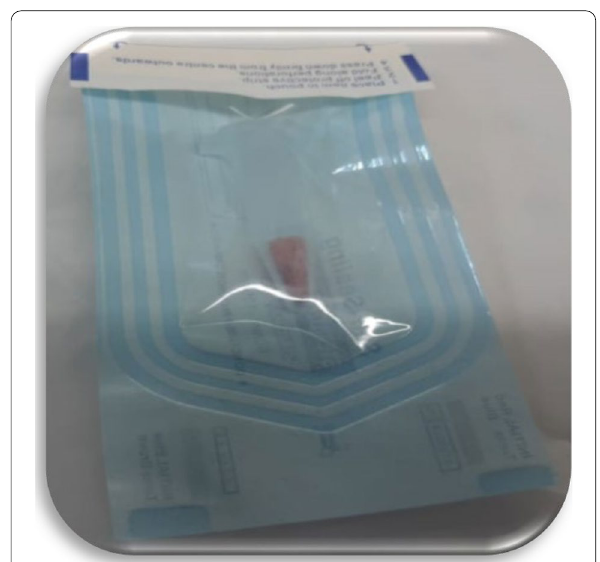
Fig. 2 Sterilized teeth in Eppendorf in sterilizing